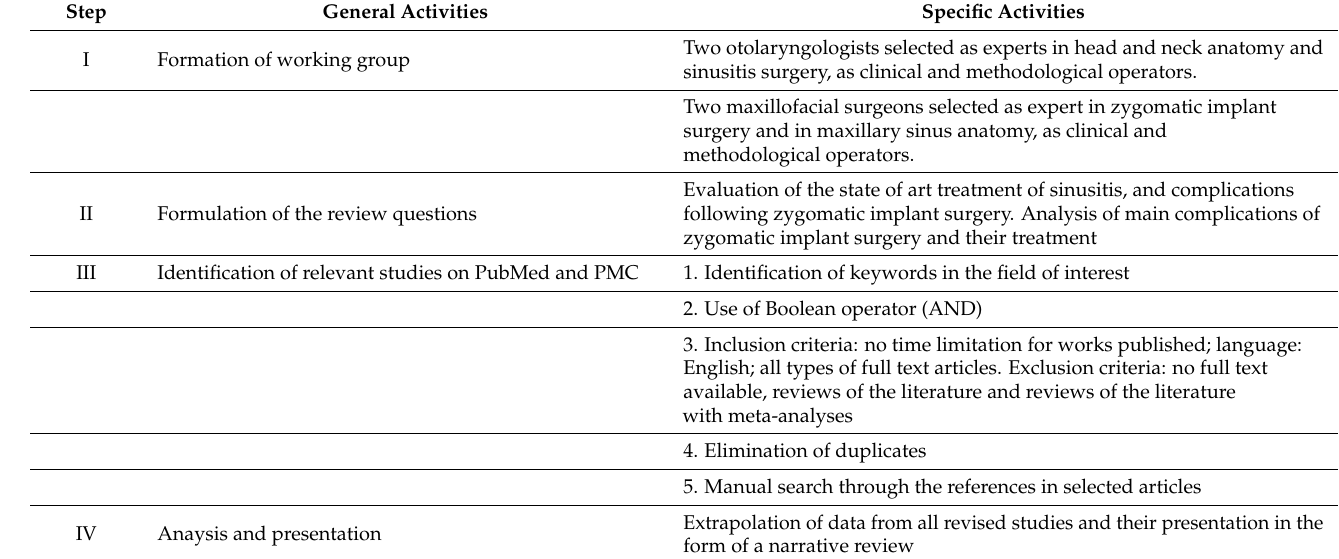
Table 1. Methodological approach to